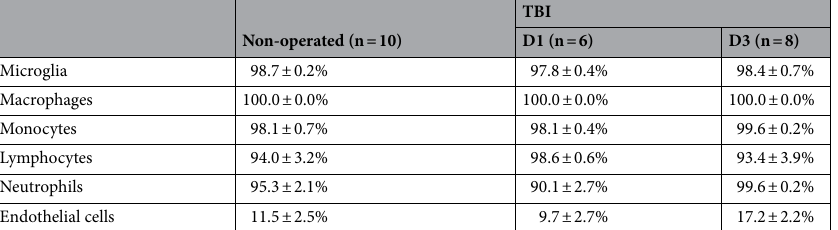
Table 2. Percentage of TSPO + cells in each cellular population in ipsilateral brain of non-operated mice and at one day and three days after TBI. Data were expressed as mean of the percentage ± S.E.M. Differences were analyzed using a one-way ANOVA followed by a Dunnett’s